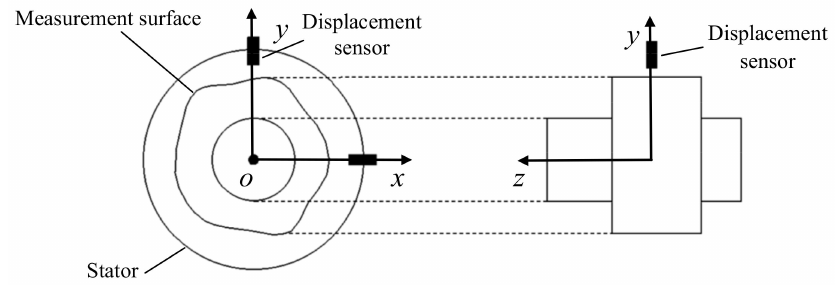
Figure 2. Mechanism diagram of sensor